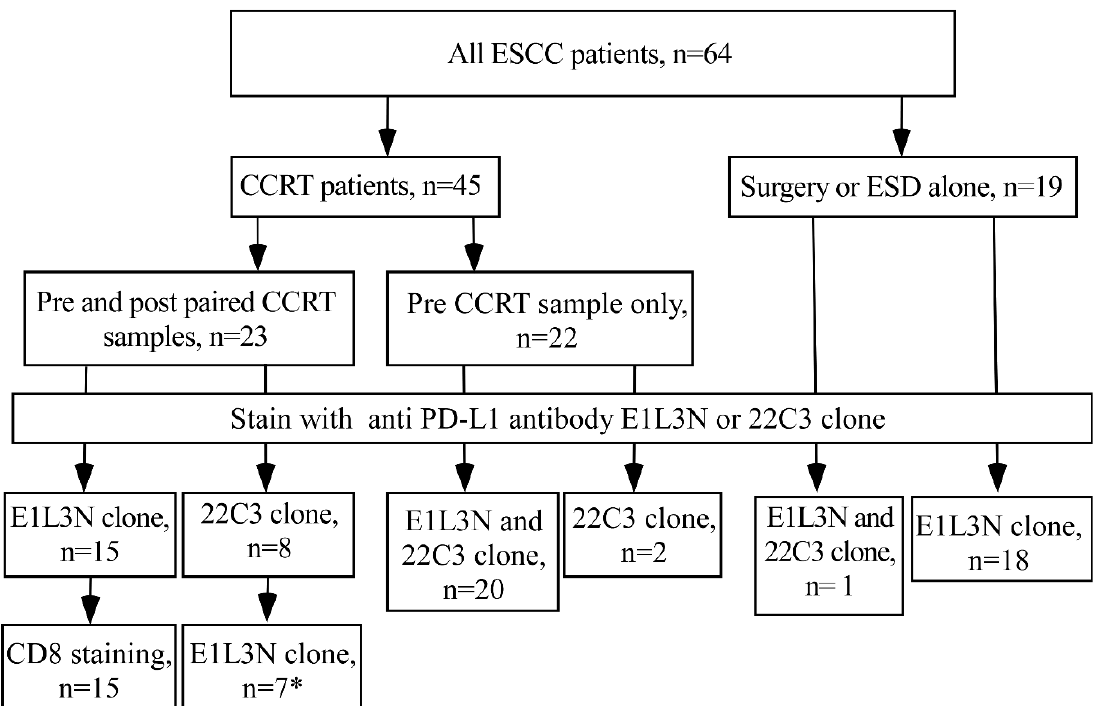
Figure 1. Study scheme and tissue staining by PD-L1 E1L3N clone antibody and/or PD-L1 22C3 clone antibody. CCRT, concurrent chemoradiation therapy; ESCC, esophageal squamous cell carcinoma; ESD, Endoscopic submucosal dissection * Due to insufficient tissue block, 3 out of 8 were stained on pre- and post-CCRT group, and 4 out of 8 were stained on pre-CCRT group.